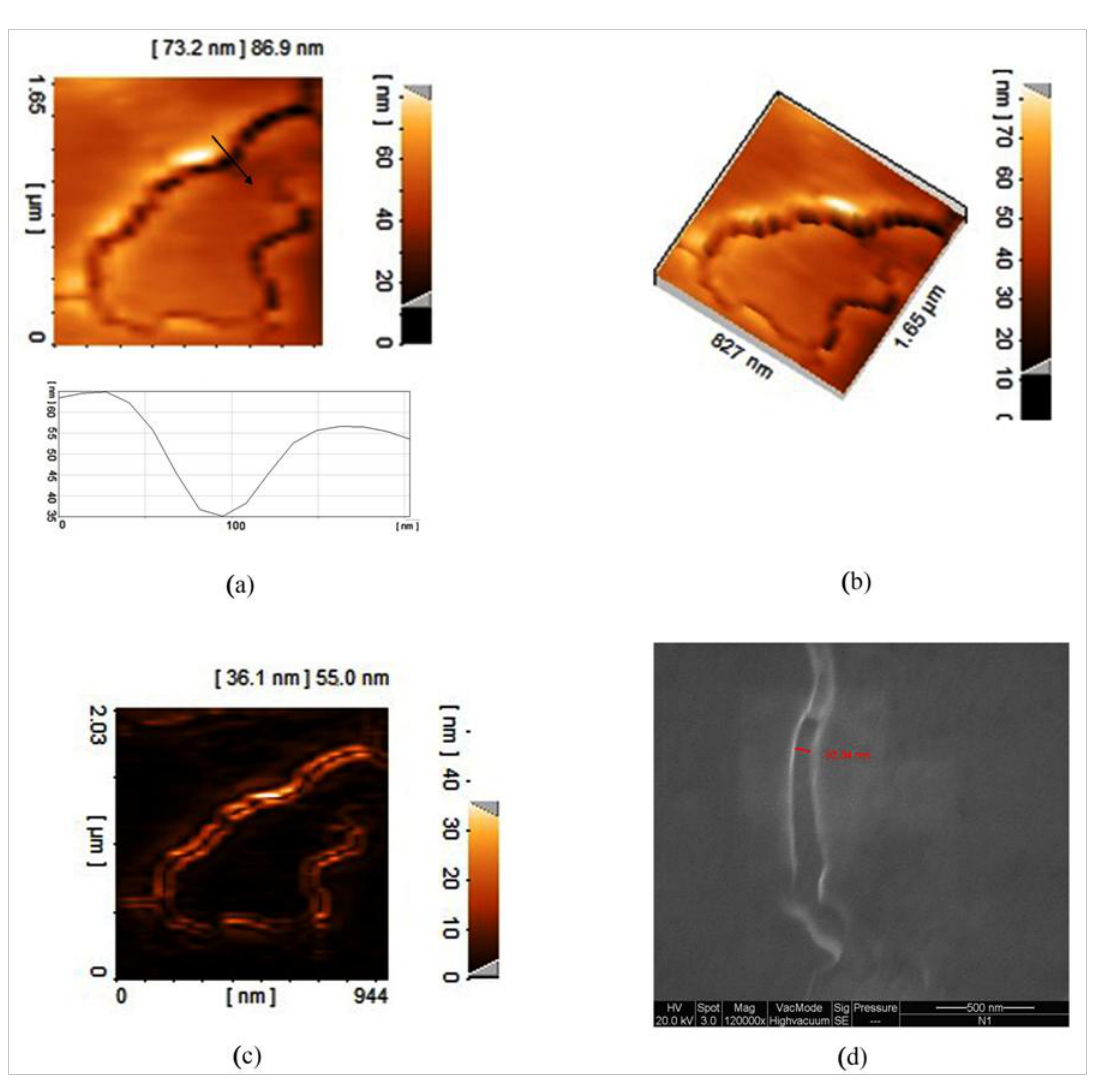
Figure 2. AFM imaging of bundled DNA strands effect n the Al thin film surface illustrate the formation of nano-gaps corresponding to the dimensions of the strands used in the experiment. ( a ) 2-Dimention image of surface; (b ) depth profile in red arrow